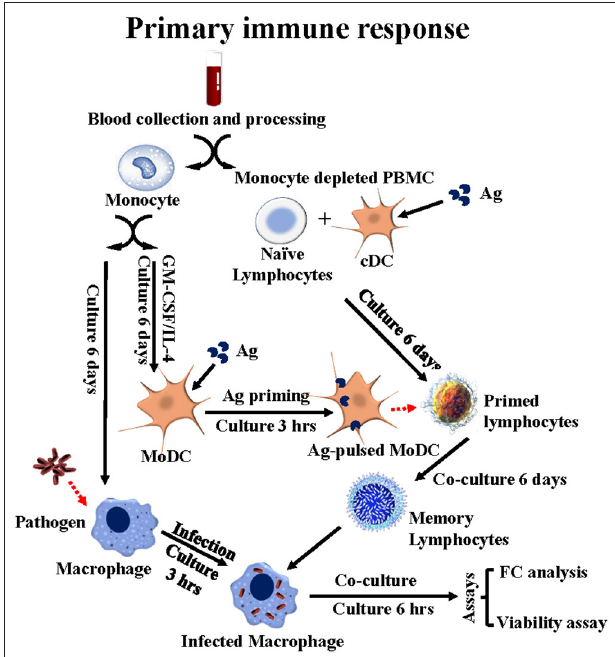
FIGURE 3 | Flow diagram illustrating the ex vivo platform developed in cattle to study the primary immune response to stimulation with APC primed with Ag. PBMC from a unvaccinated steer are separated into monocytes and monocyte-depleted PBMC (mdPBMC). The monocytes are stimulated with GM-CSF and IL-4 to generate CD209 + MoDC. The mdPBMC, containing CD209 + bDC, are stimulated with Ag. At 6 days the MoDC are primed with Ag and used to restimulate the primed mdPBMC. A second set of monocytes are isolated and cultured to generate macrophage target cells. At 6 days post stimulation with Ag primed MoDC, the mdPBMC are mixed with the infected target cells. At 6 or 24h, FC is used to phenotype the CD45R0 + memory lymphocytes. The bacteria viability assay is used to determine the extent of killing of intracellular bacteria mediated by CD8 CTL.